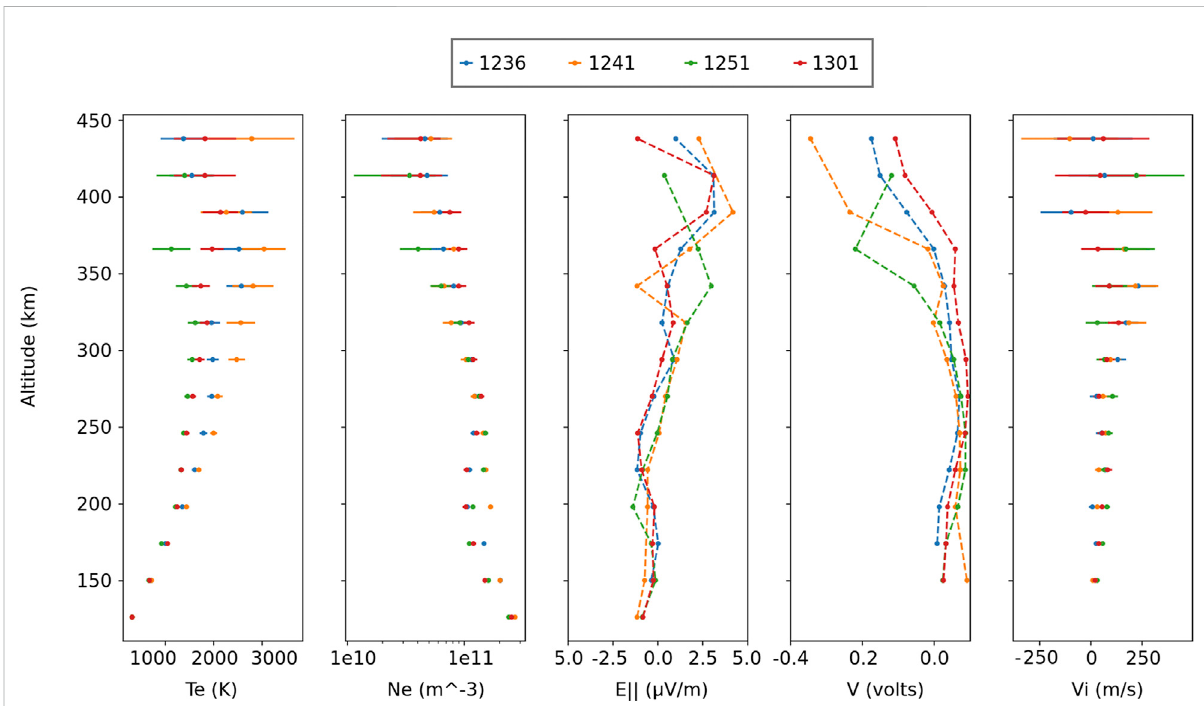
FIGURE 6 Relevant parameters are shown here for the times indicated (UT). From left to right: electron temperature, electron density, ambipolar electric fi eld, fi eldalignedpotential,andionline-of-sightvelocity,withthealtitudeofthemeasurementindicatedbythe y -axis.DataarefromthePFISRBeam 7, which is oriented along the local magnetic fi eld line. In panel, the data has been averaged over altitude for each time